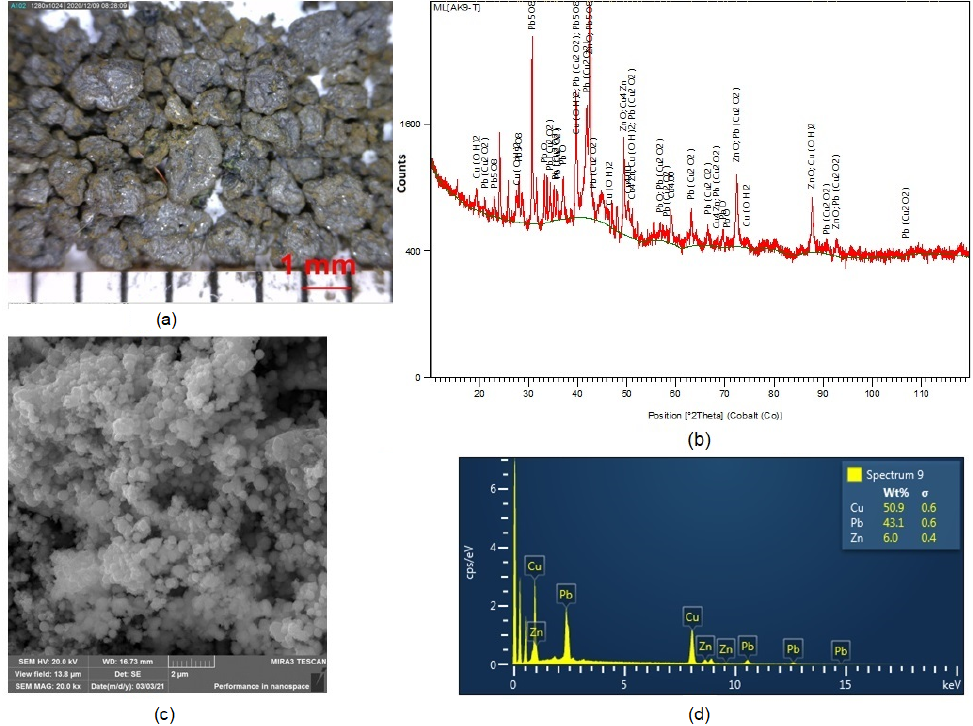
Figure 6. ( a ) Image showing morphology of cementation precipitate particles; ( b ) XRD analysis of precipitate; ( c ) SEM image of precipitate particle morphology; ( d ) EDX analysis after cementation using powder zinc.